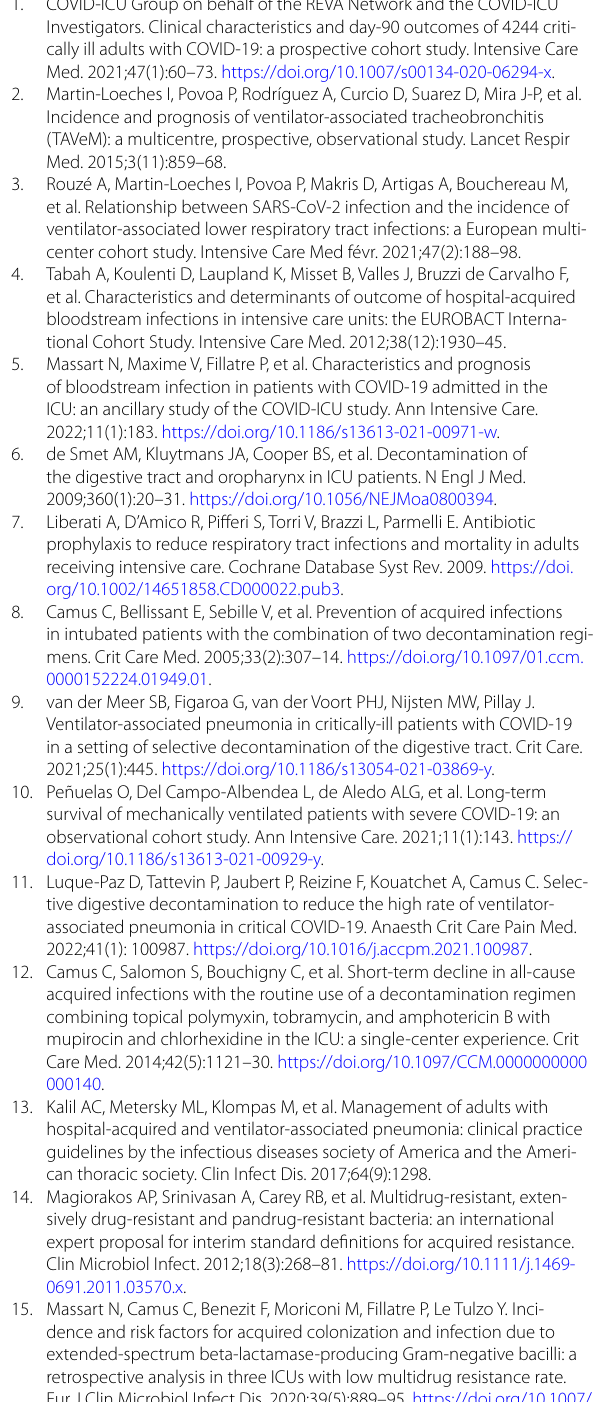
death. Figure S1. Survival curves in patients receiving MSD or not in whole population (inclusion of the 153 patients with missing data regard‑ ing